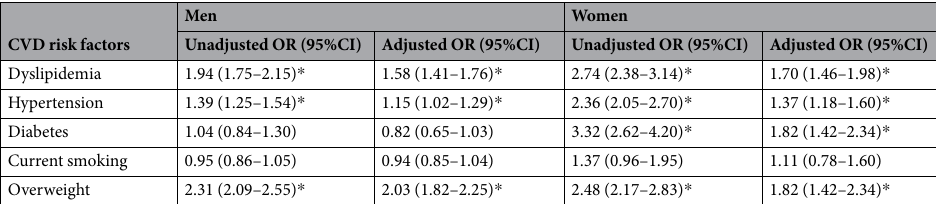
Table 4. OR and 95%CI of hyperuricemia associated with major CVD risk factors. Age, ethnicity and all other risk factors were adjusted when estimate odds ratios (ORs) with 95% confidence intervals (CIs) of each variable. * p < 0.01.